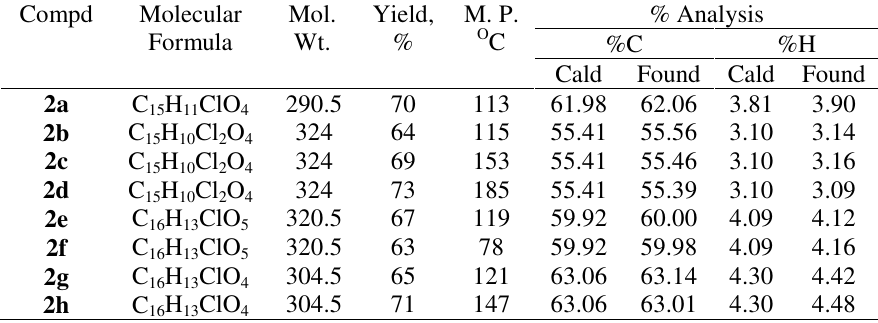
Table 1. The physical and analytical data of compounds